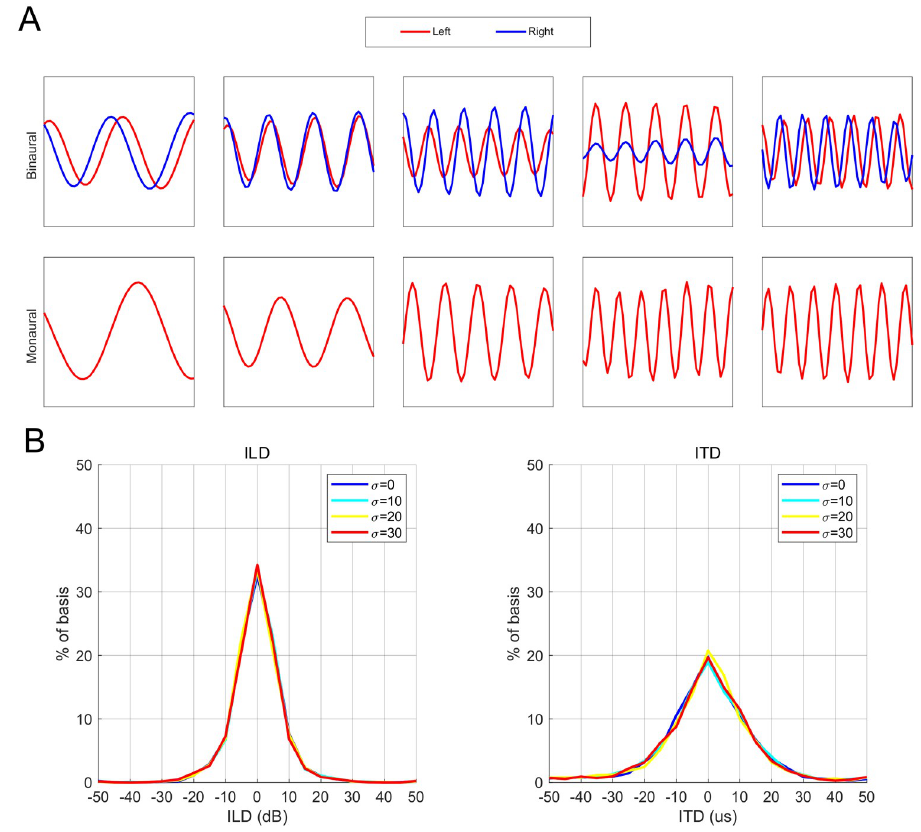
Fig 5. Basis vectors in the perceptual representation. (A) Binaural and monaural basis vectors. The binaural basis vectors comprise left and right (red and blue) components. The monaural basis vectors corresponding to the left (red) monaural GASSOM are shown here. (B) The distribution of interaural level, time differences of the binaural basis vectors. The mean percentage of the basis vectors are shown.